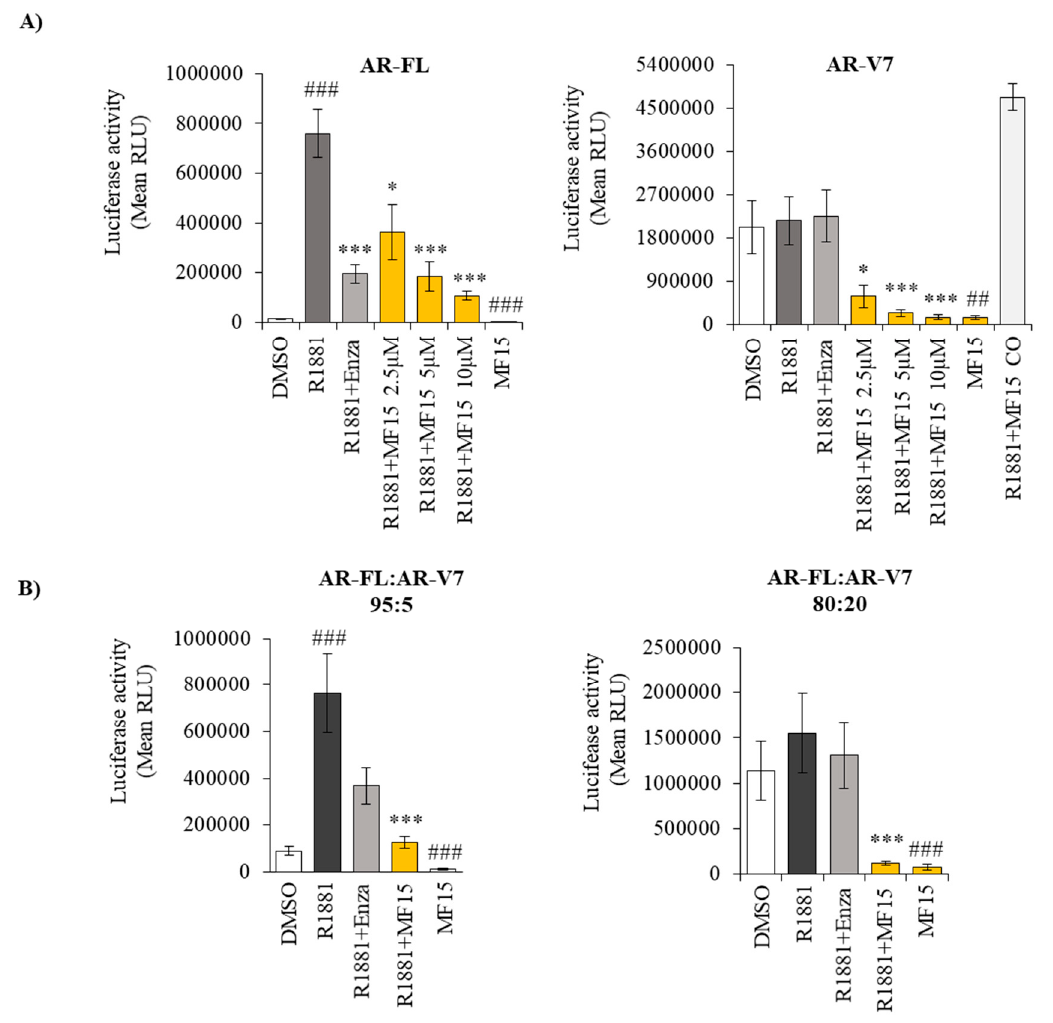
Figure 5. MF-15 inhibits AR-FL and AR-V7 reporter gene activity. ( A ) AR negative PC-3 cells were transiently transfected with full-length AR (AR-FL) or AR-V7 alone and seeded into 96-well plates in RPMI + 2% FCS supplemented with 10 µ M MF-15 alone or with increasing concentrations of MF-15 or 5 µ M enzalutamide (Enza) and 0.2 nM of the synthetic androgen R1881. To exclude unspecific interpolation of MF-15 with the assay, luciferase activity was measured following treatment of transfected cells with 0.2 nM R1881 and 10 µ M MF-15 for 2 h (R1881 + MF-15 CO). ( B ) PC-3 cells were transiently transfected with AR-FL and AR-V7 at di ff erent ratios (95:5 and 80:20) and treated with 10 µ M MF-15 alone or with 10 µ M MF-15 or 2.5 µ M enzalutamide and 0.2 nM R1881. Luciferase reporter gene activity was determined with Nano Glow Dual Assay (Promega) by measuring absorbance on a CYTATION multiplate reader instrument. Data represent the mean ± SEM from three independent experiments. Statistical comparisons to the mock control were expressed in the graph with a hash key (## p < 0.01, ### p < 0.001) and comparisons to R1881 with an asterisk (*) (* p < 0.05, *** p <